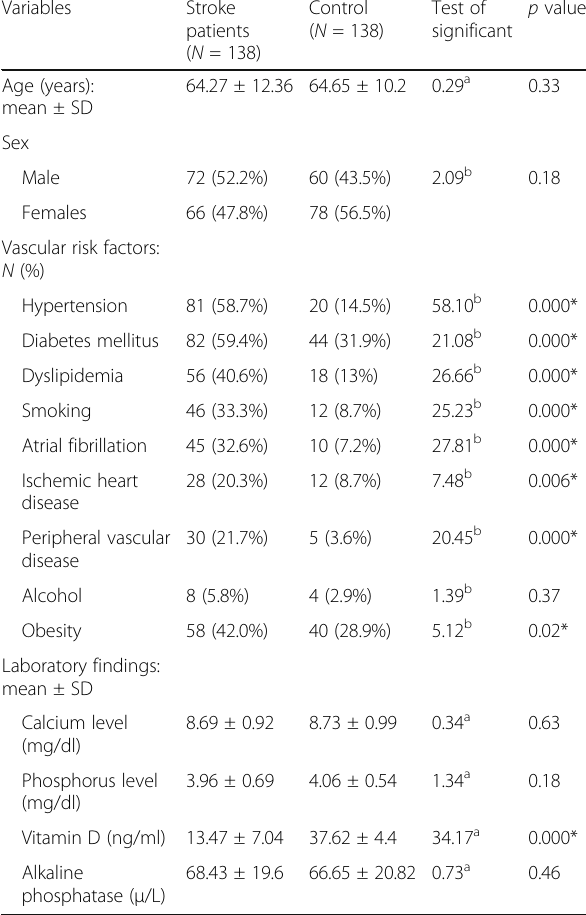
Table 1 Baseline characteristics of patients and